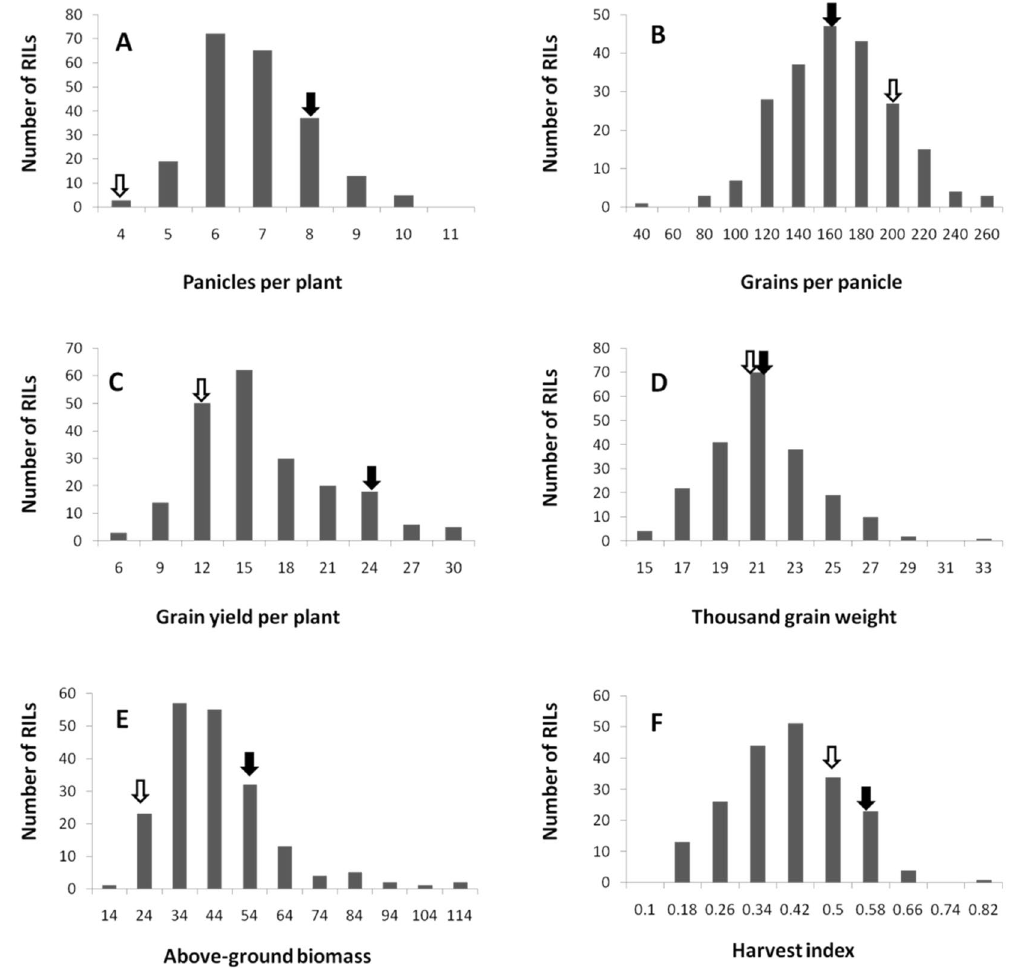
Figure 3. Frequency distribution of phenotypes for yield traits in the RILs population. ( A ) Frequency distribution of panicles per plant. ( B ) Frequency distribution of grains per panicle. ( C ) Frequency distribution of grain yield per plant. ( D ) Frequency distribution of thousand grain weight. ( E ) Frequency distribution of above-ground biomass. ( F ) Frequency distribution of harvest index. Black arrows represent trait means of R998, while white arrows indicate trait means of Francis.